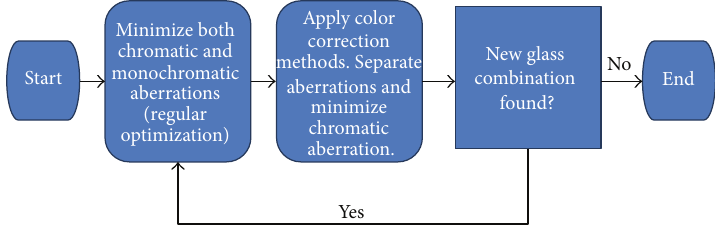
Figure 4: Suggested algorithm for application of presented methods.